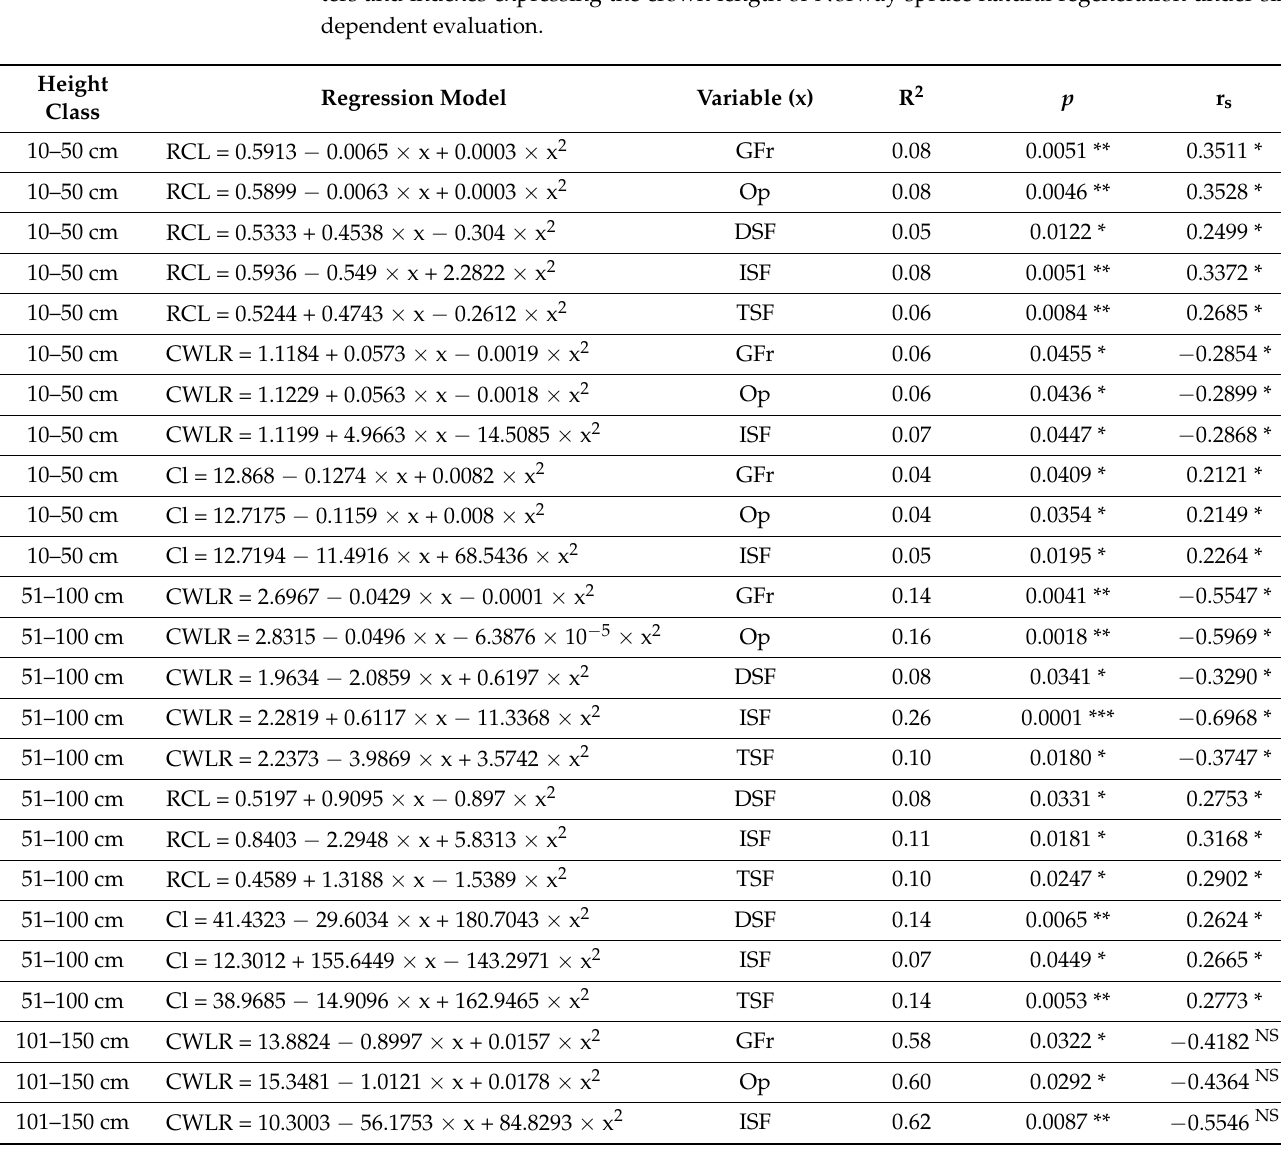
Table A4. Significantly proved regression models of light intensities and morphological parame- ters and indexes expressing the crown length of Norway spruce natural regeneration under size- dependent